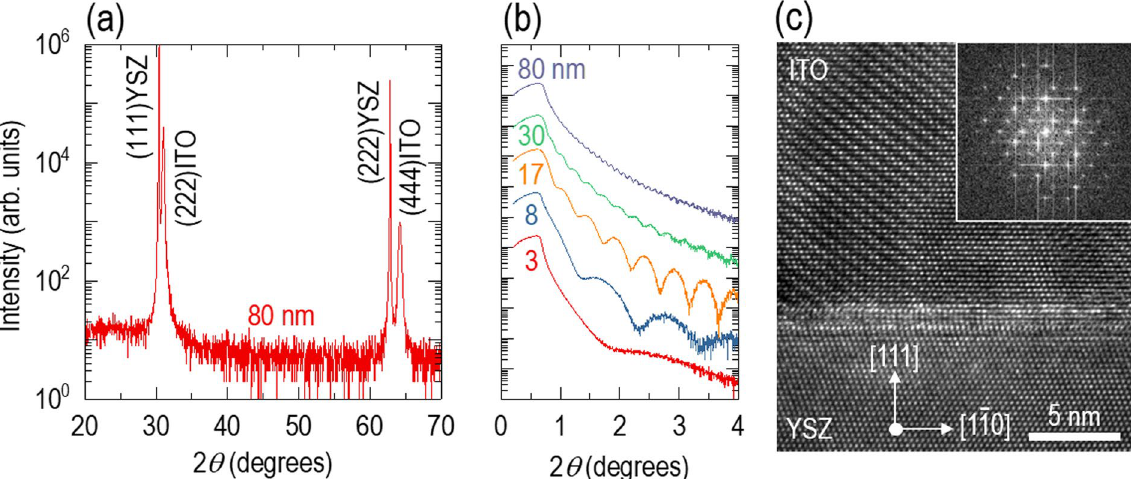
Figure 1. Single-crystalline Sn-doped In 2 O 3 (ITO) epitaxial films grown on (111)-oriented Y-stabilized ZrO 2 (YSZ). ( a ) X-ray diffraction θ − 2 θ scan of an 80-nm-thick ITO film. There are four peaks corresponding to {111}YSZ and {222}ITO, indicating epitaxial growth of the ITO film. ( b ) X-ray reflectivity of various thickness ITO epitaxial films. There are clear fringe patterns for all thicknesses, indicating that the interface and surface are smooth. ( c ) Cross-sectional transmission electron microscopy image of the 80-nm-thick film. It shows a well-ordered atomic arrangement and a smooth interface. The fast Fourier transform image also reveals single- crystalline growth of the cubic ITO epitaxial